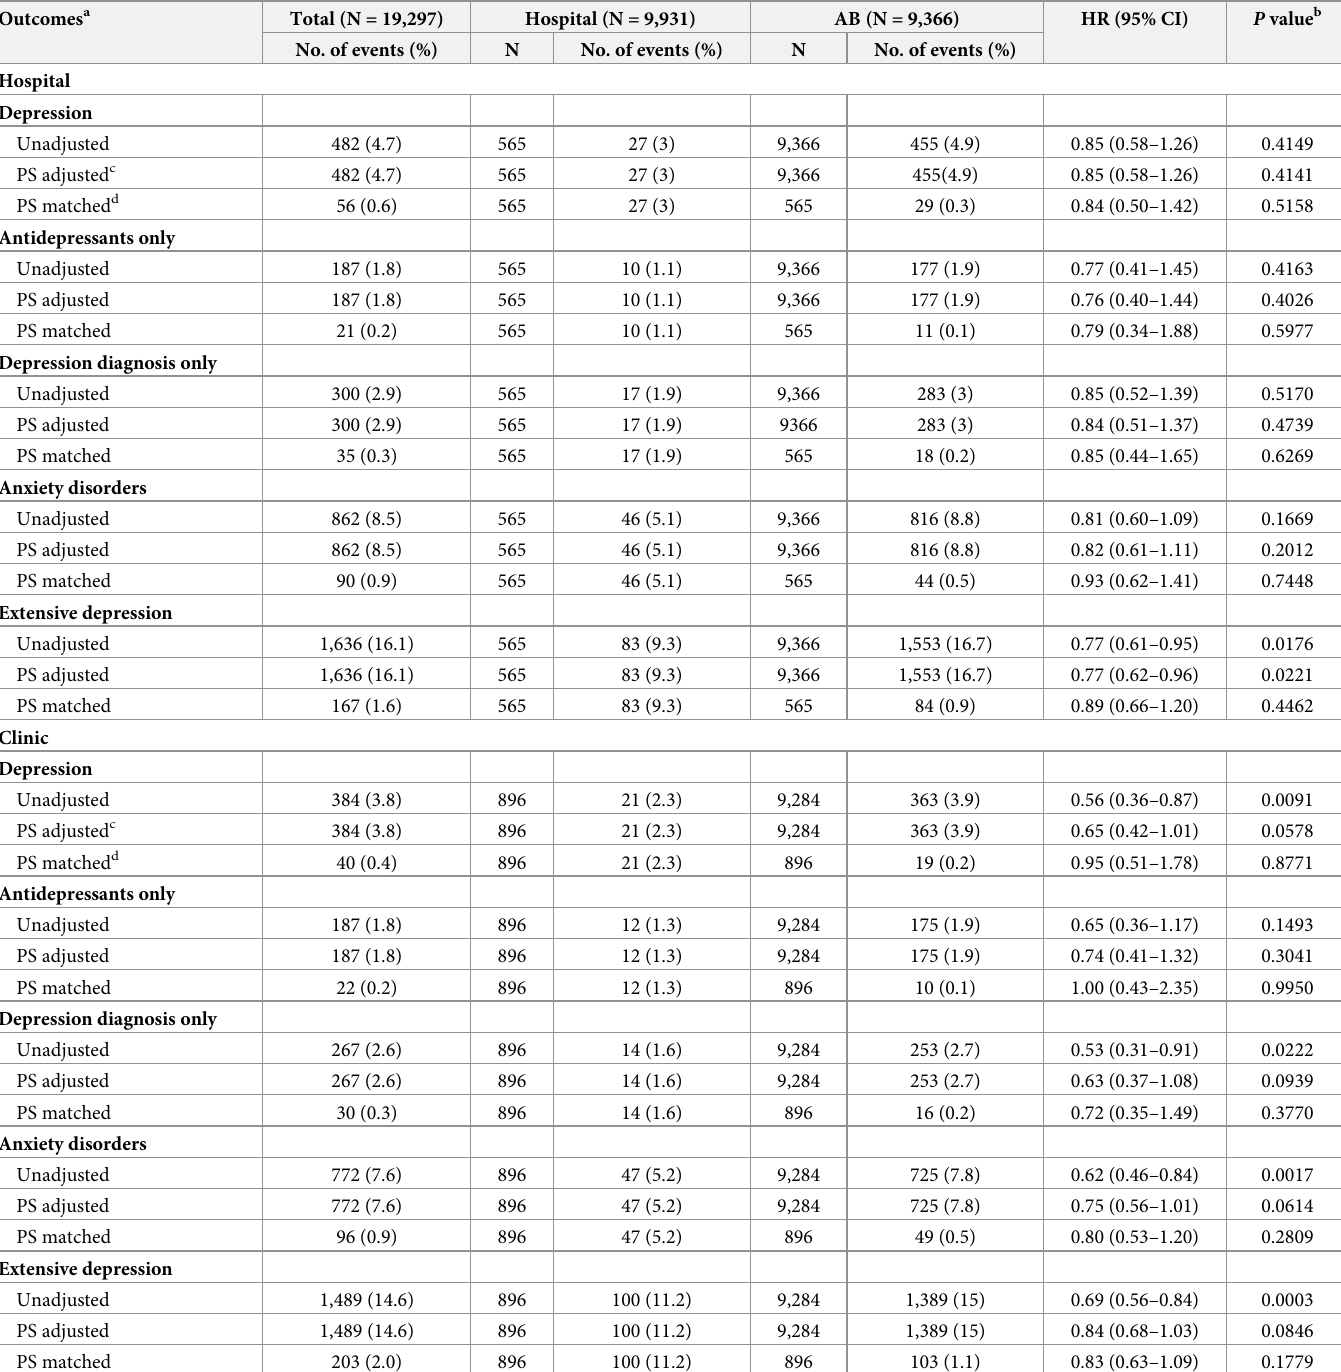
Table 4. Risk of depression anxiety disorders and extensive depression outcomes among BPH patients stratified by medical institution type at index date of